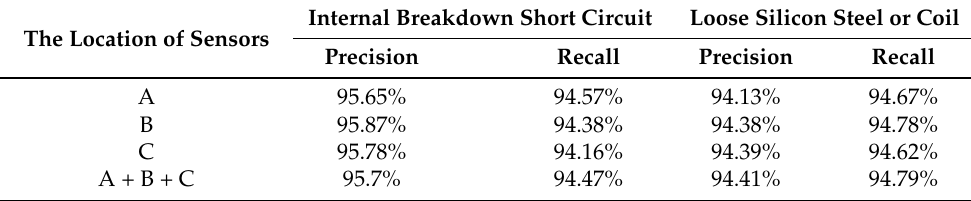
Table 3. Performance comparison with different locations and numbers of sensors. Internal Breakdown Short The Location of Sensors